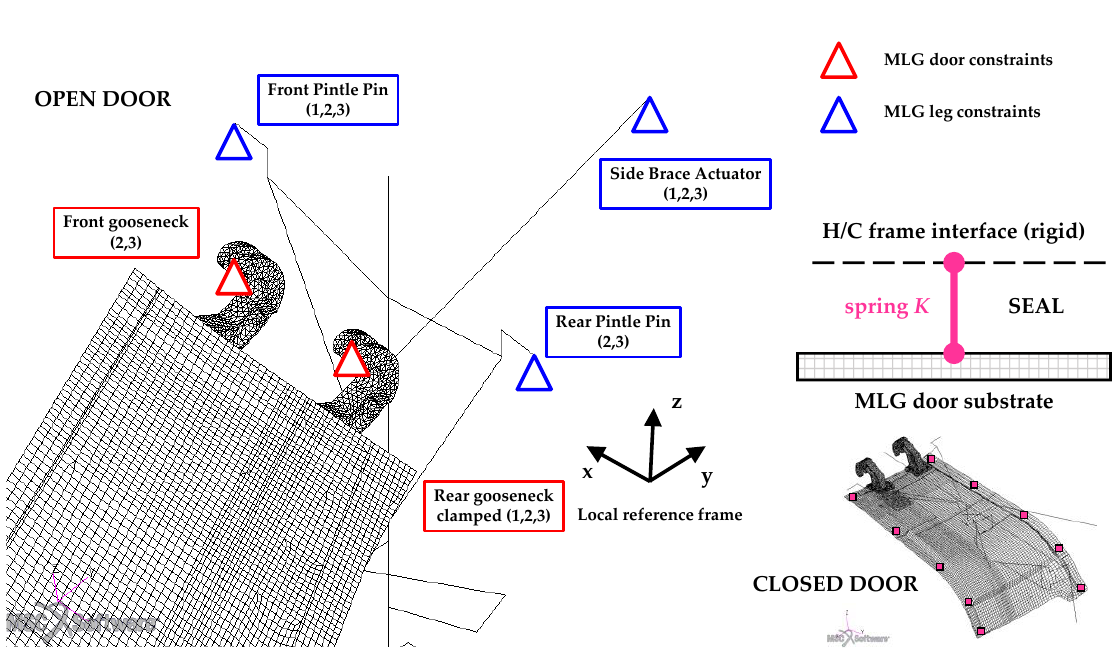
Figure 7. Boundary conditions details: MLG leg, H/C, and additional elastic constraints to be considered when the door is closed. Table 3. Damping evaluation (ESDU values)